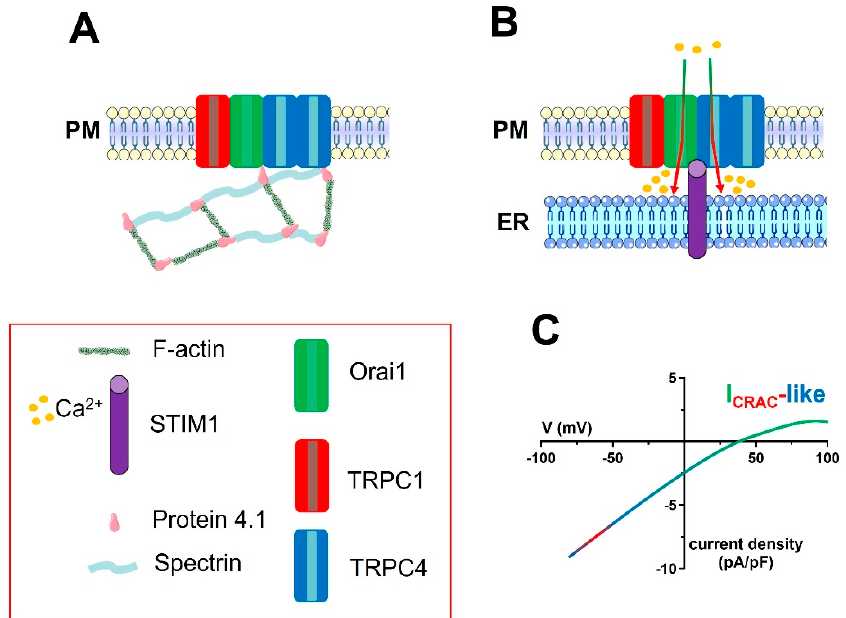
Figure 4. The molecular architecture of the I CRAC -like channel in vascular endothelial cells. A series of studies carried out on rPAECs demonstrated that the ion channel signalplex mediating the endothelial I CRAC − like currents is contributed to by one TRPC1 subunit and two TRPC4 subunits, as well as by Orai1, and is located within caveolae. TRPC4 is physically associated with both Orai1 and the actin-binding protein, protein 4.1. The latter, in turn, must be associated with the spectrin membrane skeleton ( A ). A reduction in [Ca 2+ ] ER (not shown) causes the STIM1-dependent activation of the ion channel signalplex on the PM ( B ). STIM1 is likely to physically interact with Orai1, TRPC1, and TRPC4, but this hypothesis remains to be experimentally probed. Orai1 incorporation into the STIM1/TRPC1/TRPC4 complex determines the Ca 2+ − selectivity of the store-operated current, which can therefore be defined as I CRAC -like ( C ). For sake of clarity, the spectrin − F-actin network beneath the plasma membrane has not been shown in Panel B.